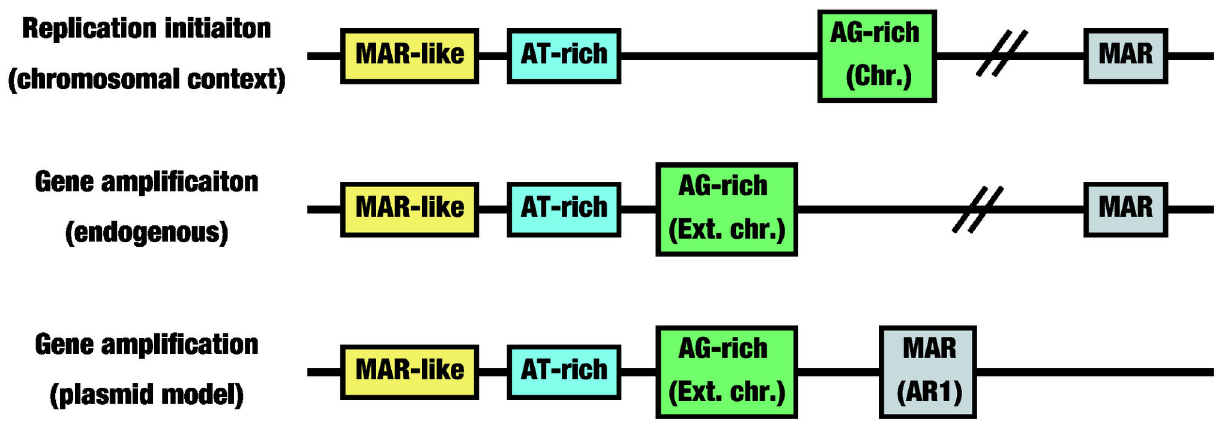
Figure 8. A model from this study. The replication initiation at the chromosomal context, the gene amplification from the endogenous chromosomal sequence and the gene amplification from the plasmid sequence require the same MAR-like element and the same AT-rich element, whereas the former one and the latter two events require similar but different AG-rich elements. The MAR elements is also required for these three events, and it is included in the plasmid (AR1) or it may be located at the chromosomal flanking region.